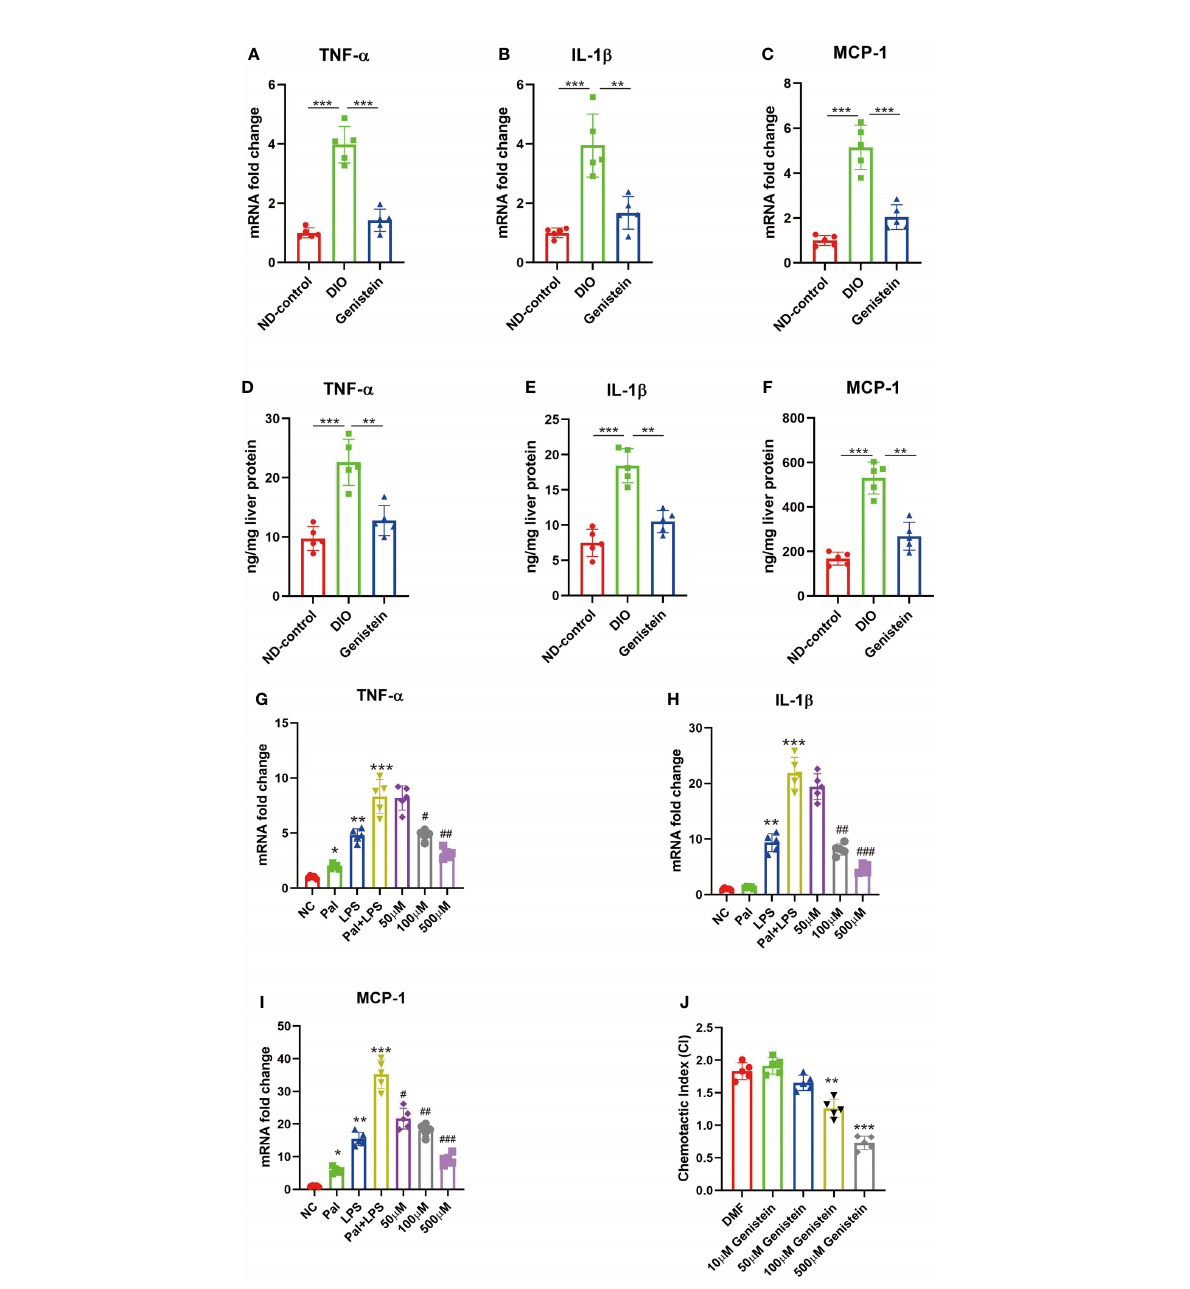
FIGURE 5 Genistein could reduce pro-in fl ammatory cytokine production and chemotactic migration in macrophages in the liver. (A – C) The mRNA levels of TNF- a , IL-1 b , and MCP-1 in the liver from different groups, tested by qPCR. (D – F) The protein levels of TNF- a , IL-1 b , and MCP-1 in the liver from different groups, tested by ELISA. The age-matched female mice received 6 weeks of normal diet (Control), HFD diet (HFD), and GE diet (HFD+0.2%GE). n = 5 in each group. (G – I) RAW 264.7 cells were stimulated with palmitic acid (Pal) followed by LPS, with or without addition of varying doses of genistein. The negative control (NC) group was only treated with the vehicle, dimethylformamide (DMF). Changes in the expression of TNF-a, IL-1 b , and MCP-1 were determined using qPCR. (J) Genistein inhibits BMDM migration toward MCP-1. BMDMs were incubated with MCP-1 in a Transwell with vehicle (DMF) or different doses of genistein. The chemotactic index (CI) for a treatment condition was calculated as the ratio of average number of migrated cells in the treatment group relative to the control group (incubated in medium only). ANOVA test was used to compare the differences among the groups. Data are presented as mean ± SEM, * stands for p < 0.05, ** stands for p < 0.01 and *** stands for p < 0.001, compared with the negative control (NC) group. For G-I, # stands for the GE stimulation group compared with the Pal+LPS stimulation group, #p < 0.05, ##p < 0.01, ###p <